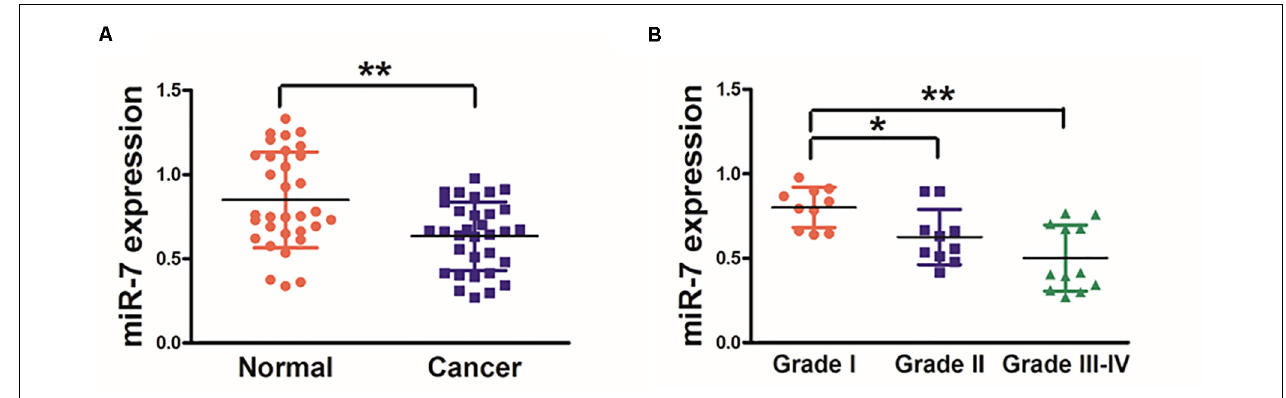
FIGURE 1 | Human GC tissues exhibit decreased miR-7 expression. (A) The expression of miR-7 was examined via qRT-PCR in 32 paired GC and adjacent normal stomach tissue samples, with U6 used for normalization. (B) A pathologist conducted histological examination of all samples, and relative miR-7 expression as a function of tumor stage is shown. Data are means ± SD. * P < 0.05; ** P < 0.01.